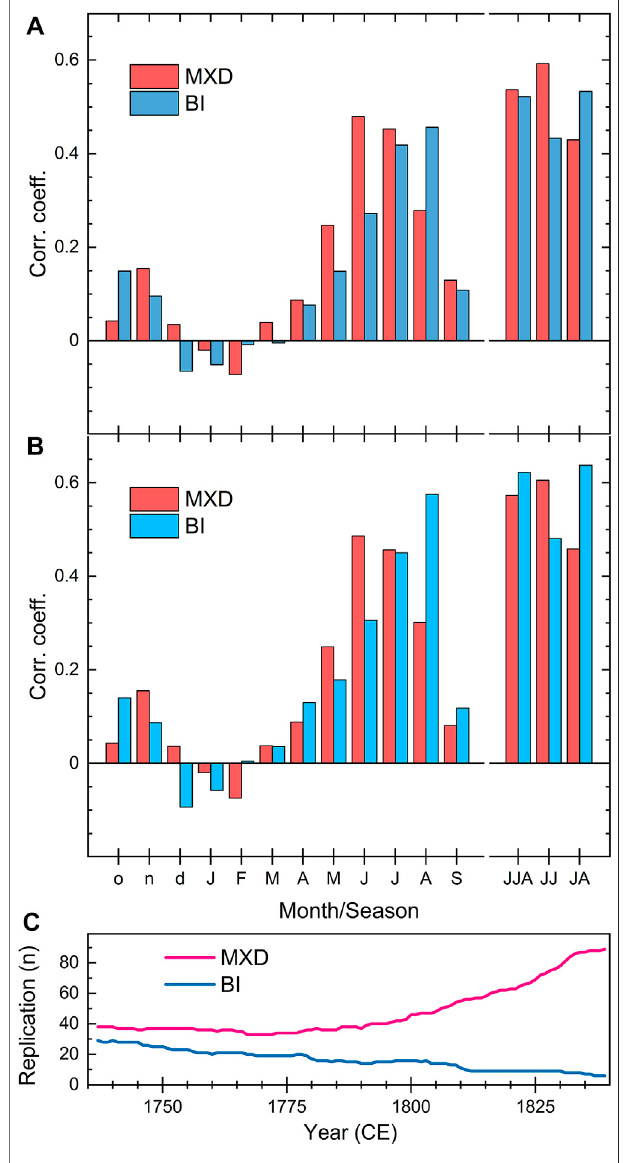
FIGURE 5 | Dendroclimatic relations. (A) Pearson correlations calculated for the full set of temperature data originating from the studies of Holopainen and Vesajoki (2001) and Helama et al. (2004a). (B) Correlations excluding the year 1815 CE. (C) Replication of maximum latewood density (MXD) of a previous study (Matskovsky and Helama 2014) and minimum blue channel light intensity of subfossil wood (BI, this study). Tree- ring records were related to monthly and seasonal temperature variables of the previous (small letters) and concurrent year (capital letters). Seasonal variables include June – August (JJA), June – July (JJ), and July – August (JA) temperatures (1737 – 1838 CE). Note the reversed vertical axis for BI correlations for comparative